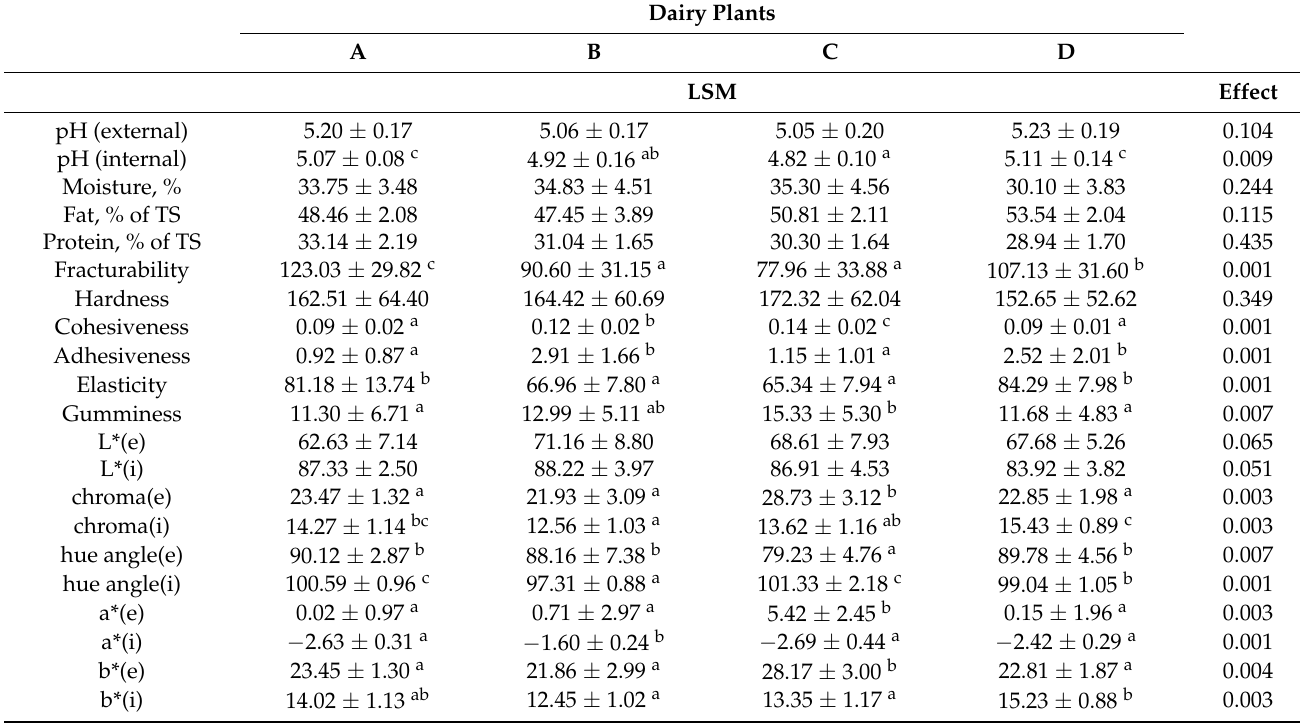
Table 5. Physicochemical composition, texture and colour attributes of Palmero cheese (30 days) from 4 dairy